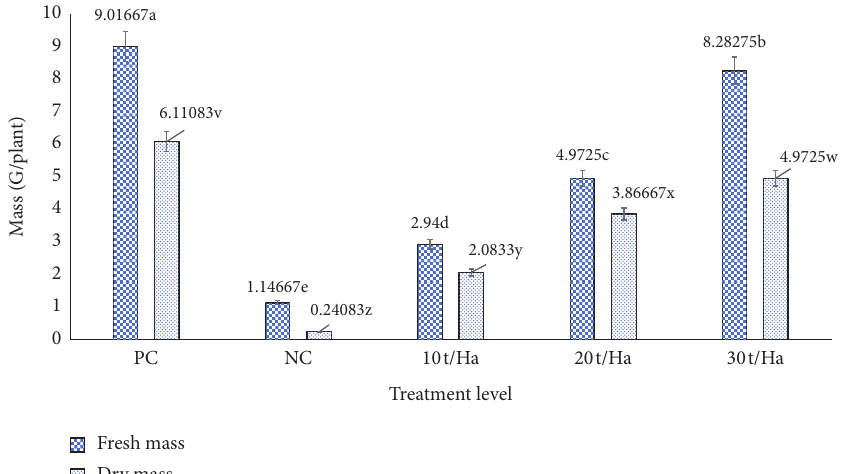
Figure 1: Above-ground fresh mass and dry mass. ∗ Means with different letters are significantly different at p < 0.05. PC � positive control. NC � negative control. t/Ha � spent mushroom rate per